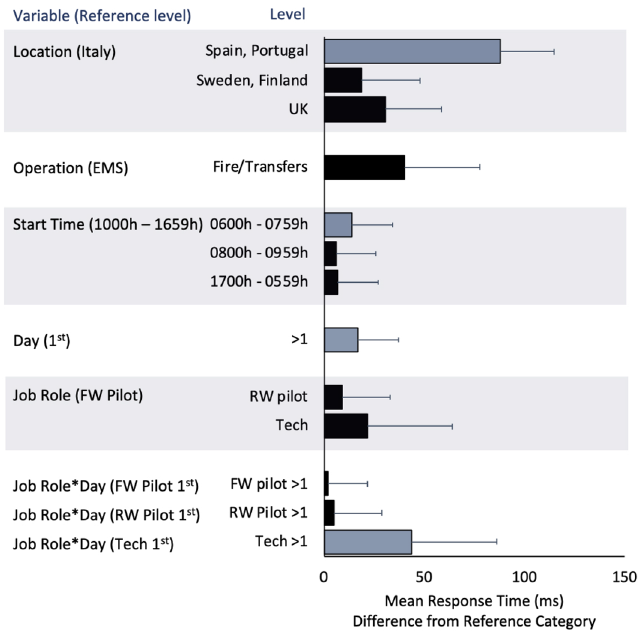
Figure 6. Psychomotor Vigilance Task (PVT) response times vary as a function of by location, shift start hour, consecutive days into duty, and job role. Differences in PVT mean response times (bars) and their standard errors (whiskers) area displayed relative to a reference level (e.g. for Location, differences in response times are shown relative to Italy). Blue bars indicate significant differences from other levels of that variable, p < 0.05. Note: EMS = Emergency Medical Service, Fire = Firefighting, Transfers = Air Taxi, SAR = Search and Rescue, FW = Fixed Wing, RW = Rotary Wing, Tech =